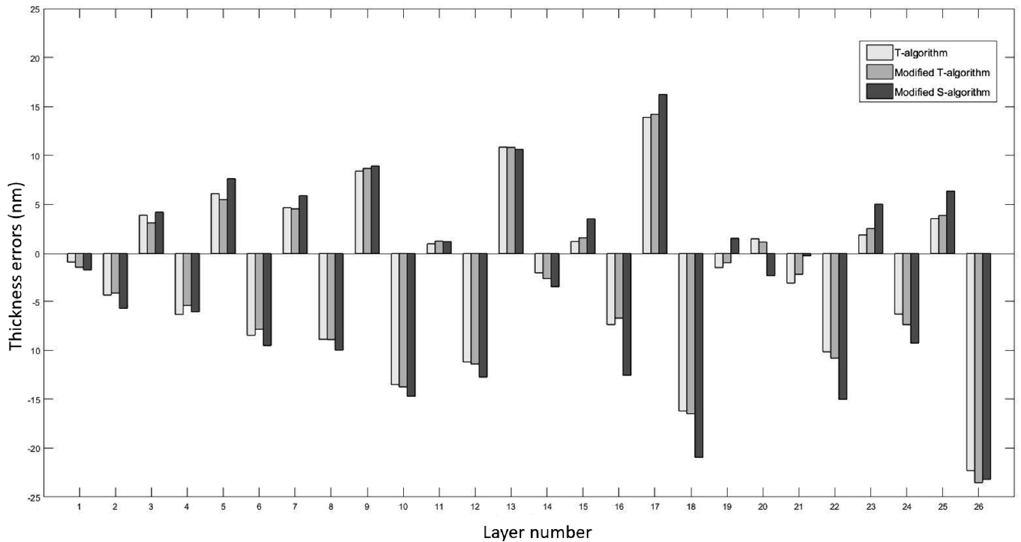
Figure 5. Results of the characterization using online transmittance data from the real deposition run: comparison between average values of thickness errors found by the investigated algorithms.